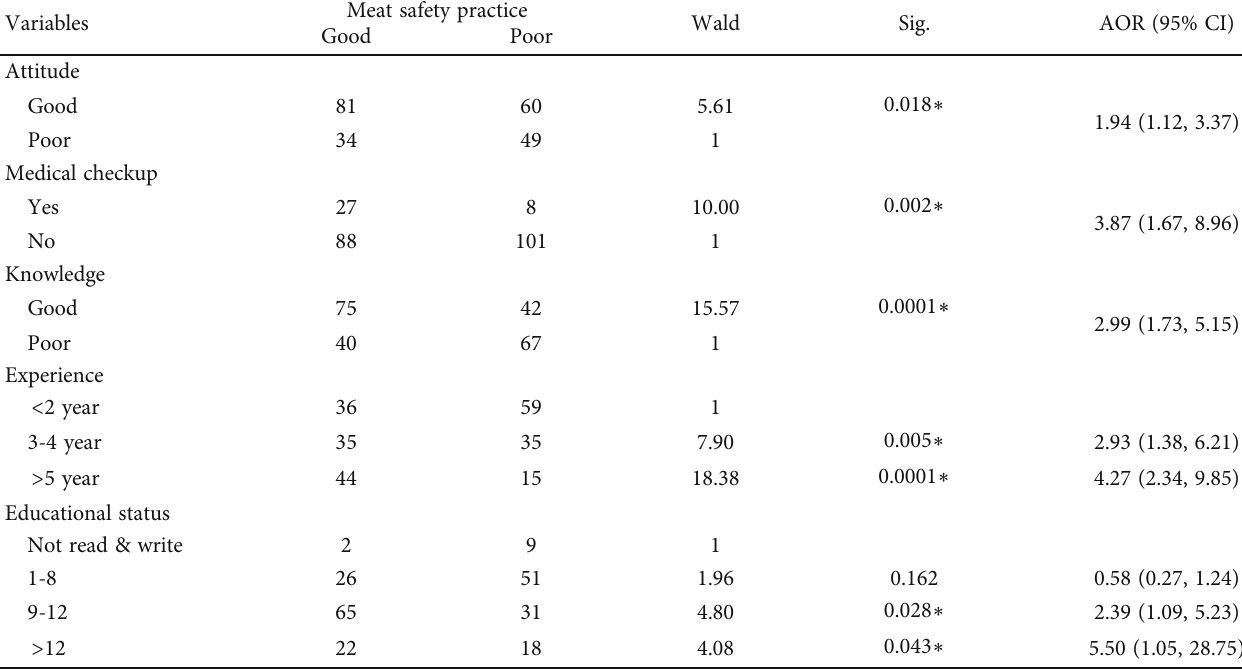
Table 3: Multivariable logistic regression of factors associated with the practice of meat handlers working in butcher shops in North Shewa Zone ( n = 224